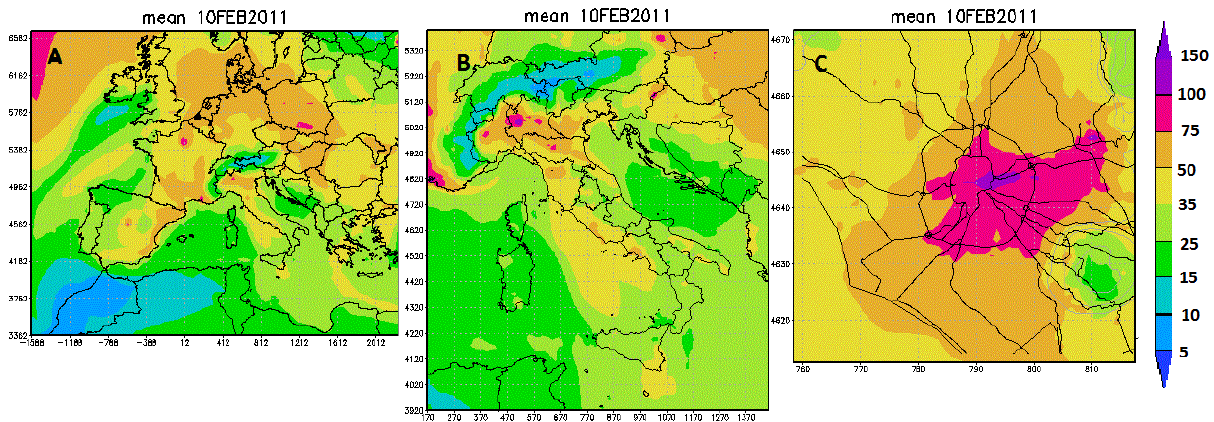
Fig. 2. The forecasted daily average concentrations of PM 10 near the ground level on 10 February 2011, provided by the FARM model in (a) Europe, (b) Italy and (c) the urban area of Rome. The horizontal grid spacing in the forecasts of these three simulations are 48, 12 and 1 km, respectively. The scales on all the axes are in km, and the concentrations are in µg/m 3 .